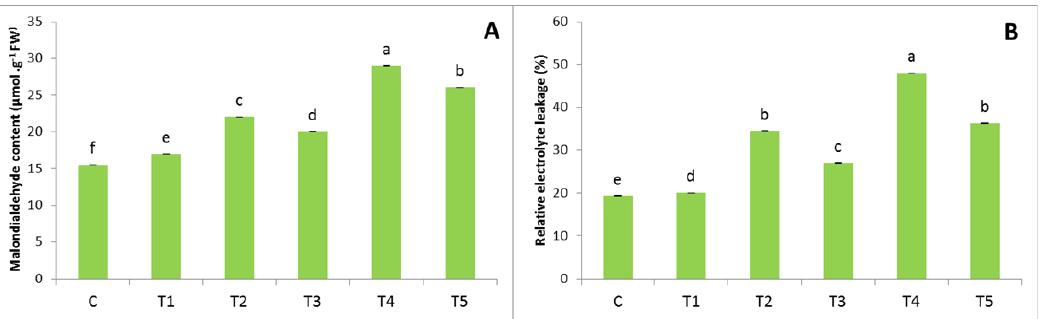
Figure 2. MDA contents ( A ) and relative electrolyte leakage ( B ) of A. rosea plants under Cd and citric acid application. The bars indicate mean values ± standard error. Where T1 = 5mM.kg -1 CA, T2 = 100 mg.kg -1 Cd, T3 = 100 mg.kg -1 + 5 mM.kg -1 , T4 = 200 mg.kg -1 Cd, and T5 = 200 mg.kg -1 + 5 mM.kg -1 . The different alphabets on the vertical bars represent significant differences among the treatments at p < 0.05.